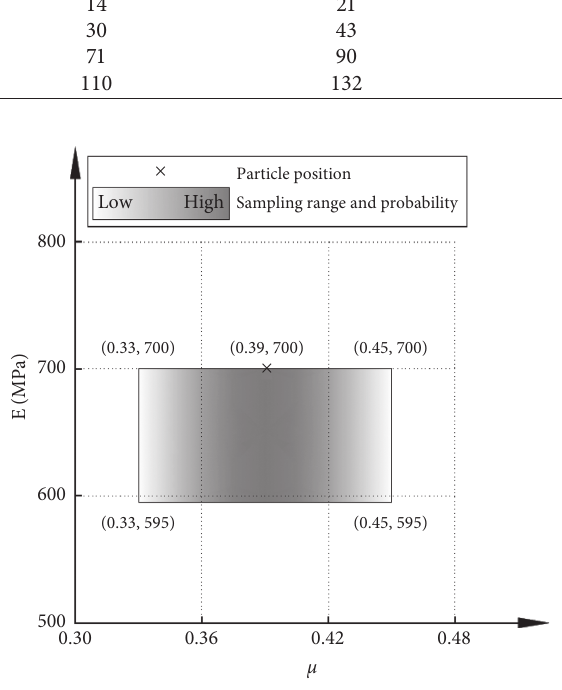
Figure 11: Sampling of the elastic modulus and friction